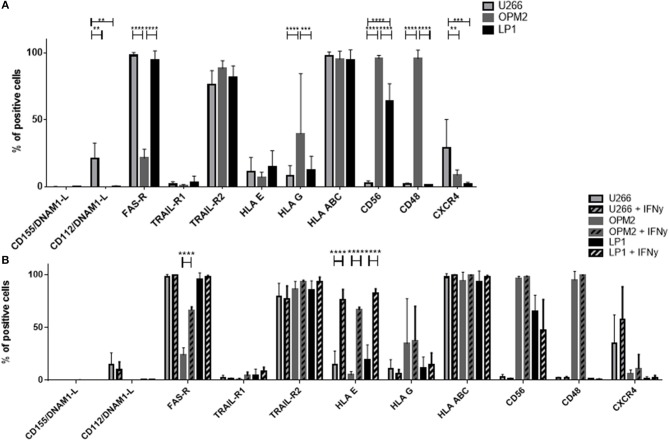
Determination of the expression of surface molecules on multiple myeloma cells. (A) The marker expression of different multiple myeloma cell lines was measured via FACS analysis by staining the cell lines LP-1 (black), OPM-2 (dark gray) and U266 (light gray) with fluorochrome-conjugated antibodies. (B) To further increase the expression of HLA-E, the multiple myeloma cell lines were incubated for 24 h with 25 nM IFN-γ before measuring surface marker expression via flow cytometry. For phenotyping the MM cells, five individual experiments were performed (n = 5). For phenotyping experiments after stimulation with IFN-γ, 3 individual experiments were performed (n = 3). Statistical analysis with two-way ANOVA + Sidak's/Tukey's multiple comparison: *p < 0.05, **p < 0.01, ***p < 0.001, ****p < 0.0001.